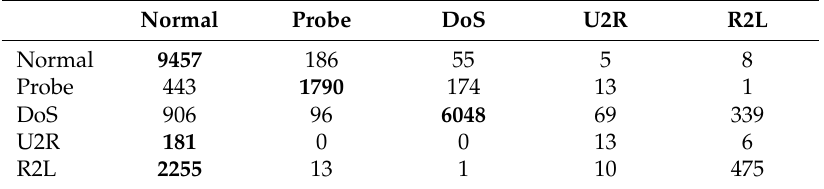
Table 7. Confusion matrix of NSL-KDD (KDDTest+) dataset with optimal parameters K and σ .